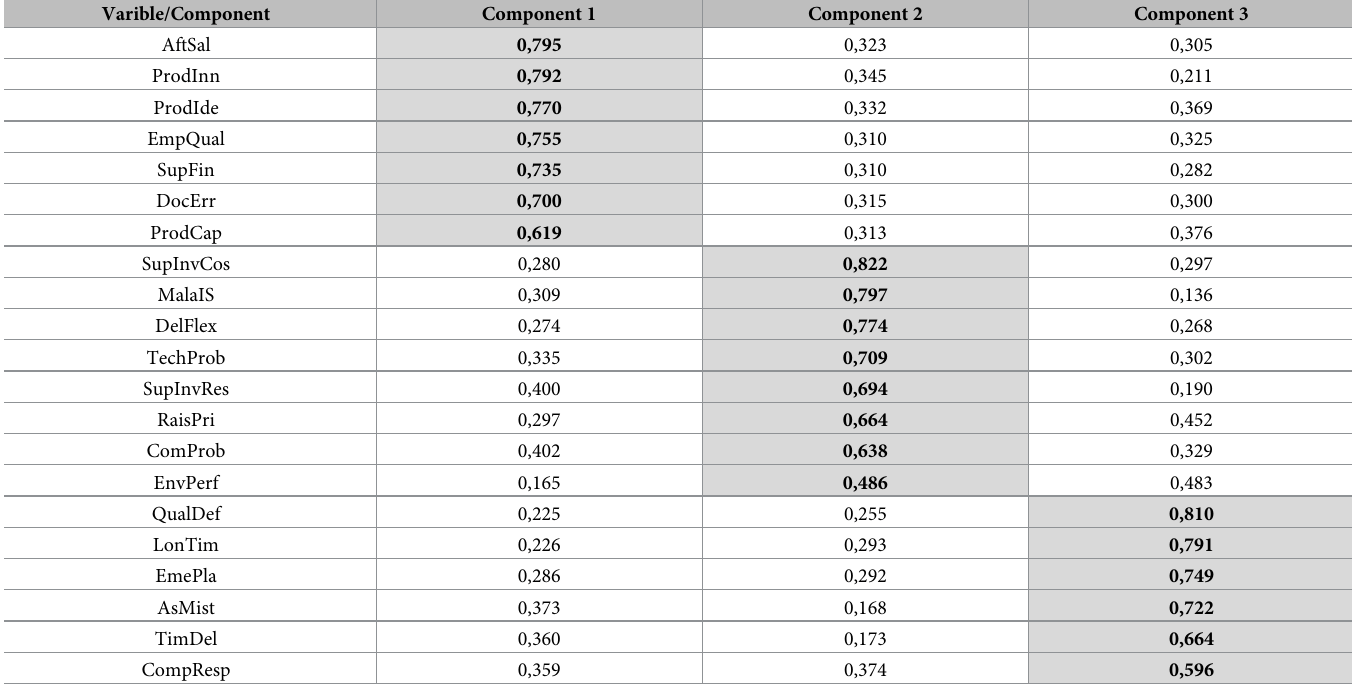
Table 4. Rotated component